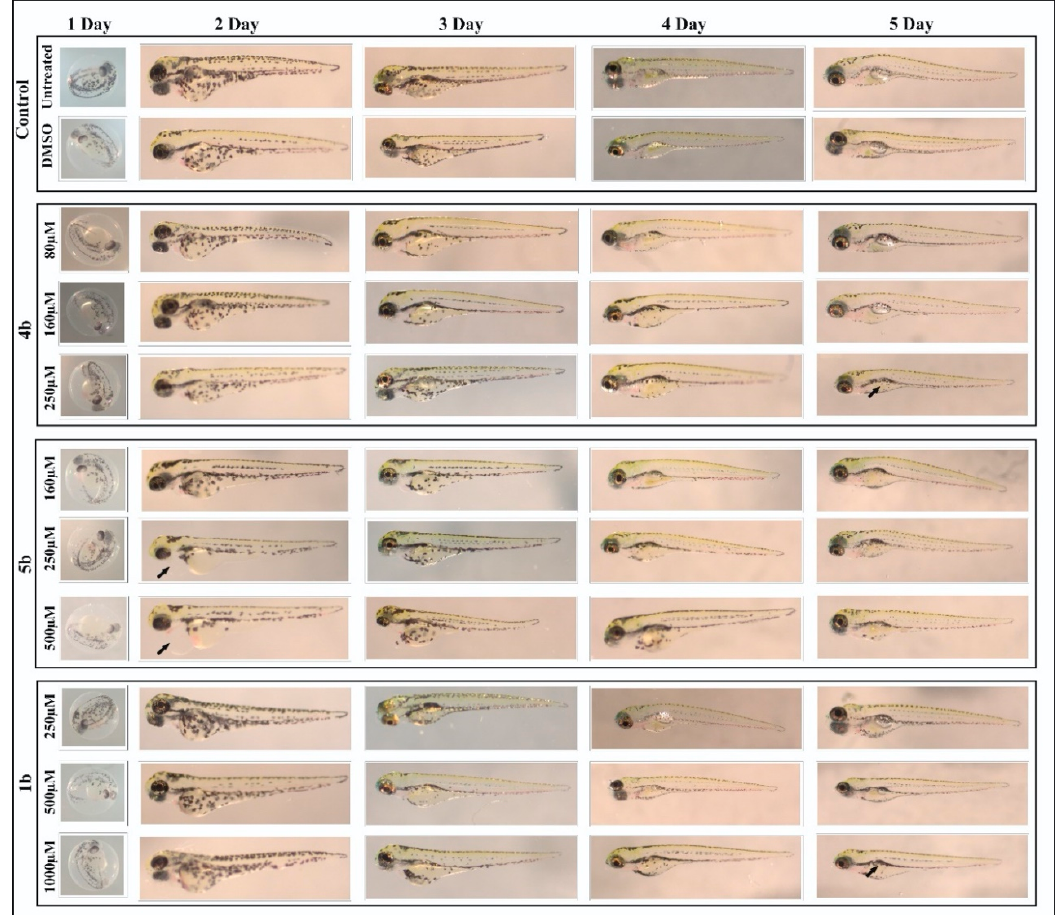
Figure 3. Lethal concentration 50 (LC 50 ) values of the prodrugs. The LC 50 doses of the compounds were calculated based on the 50% mortality of the developing larvae at the end of five days after the exposure of embryos to different concentrations of inhibitors. ( A ) The ranges of LC 50 values of compound 4b (< 500µM concentration). ( B ) The LC 50 value for compound 5b was below 1000 µM and ( C ) compound 1b showed an LC 50 value of about 1400 µM. The LC 50 doses were determined after three independent experiments with similar experimental conditions (N = 72 larvae).